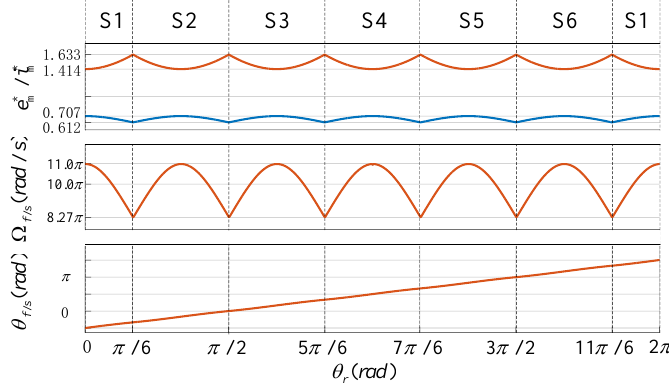
Figure 4. The waveforms of vector modulus, angular velocity, and angle with current optimizing control (COC): ( up ) modulus of current vector (blue) and back-EMF (red); ( middle ) angular velocity of current vector (blue) and back-EMF vector (red); ( down ) angles of current vector (blue) and back-EMF vector (red).